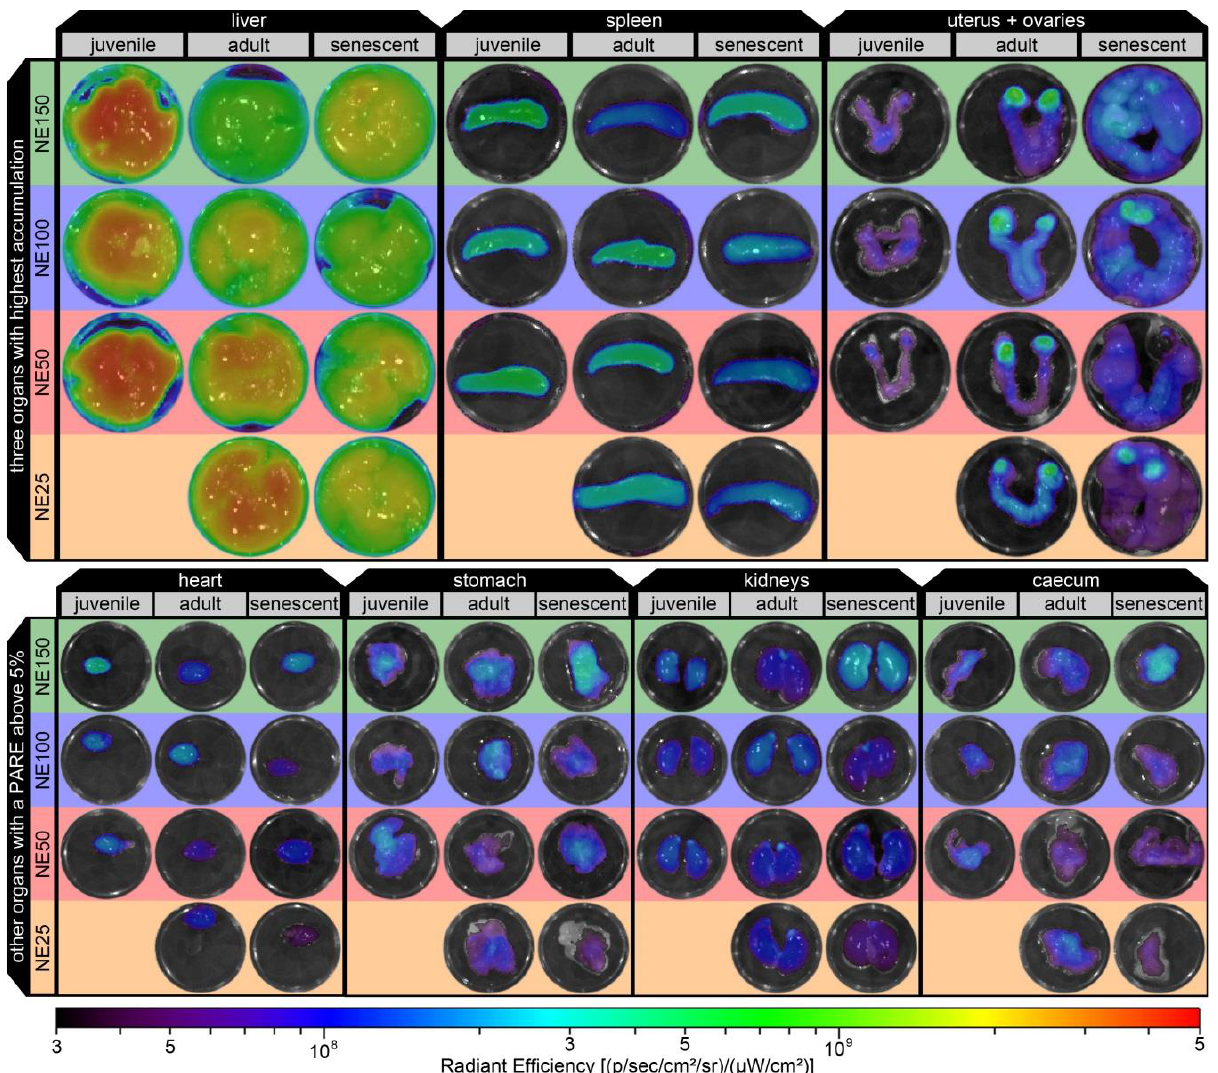
Figure 8. Ex vivo fluorescence images of the excised organs with the highest accumulation (liver, spleen, uterus +ovaries, heart, stomach, kidneys, and caecum) of the representative mice.